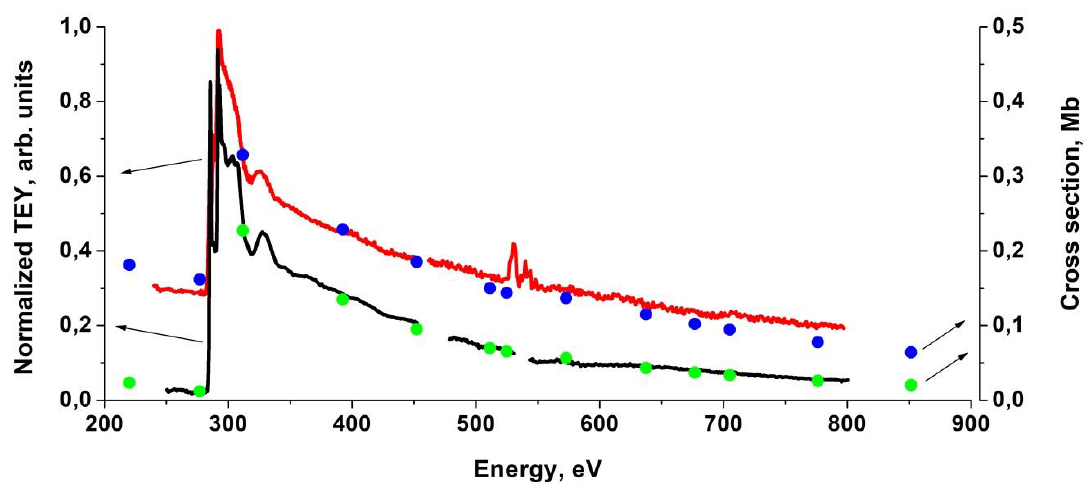
Figure 6. The normalized total electron yield (TEY) signal of MWCNTs (black) and nanocomposite Sample 2 (red) in arbitrary units ( left scale ) and atomic cross sections sums [67] C(97%) + O(3%) (green), W(10%) + C(80%) + O(10%) (blue) in Megabarns ( right scale ).